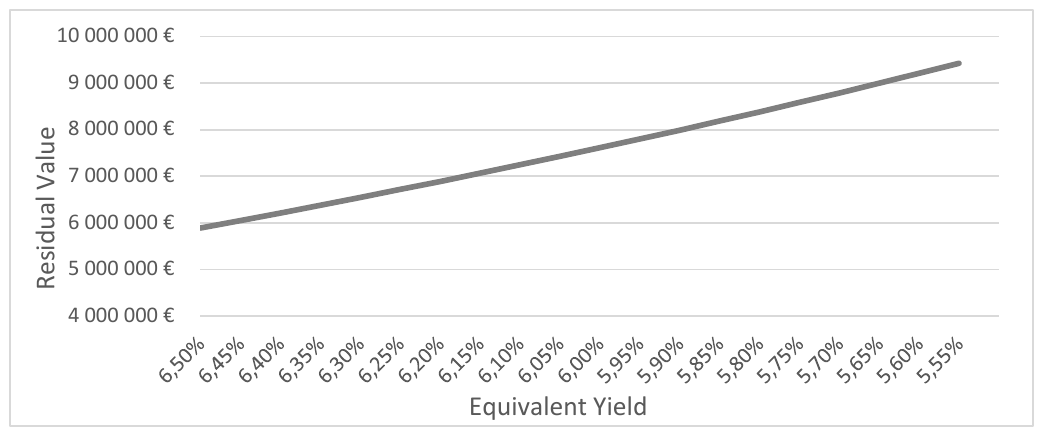
Figure 3: Sensitivity of residual value on EY (source: Autor)